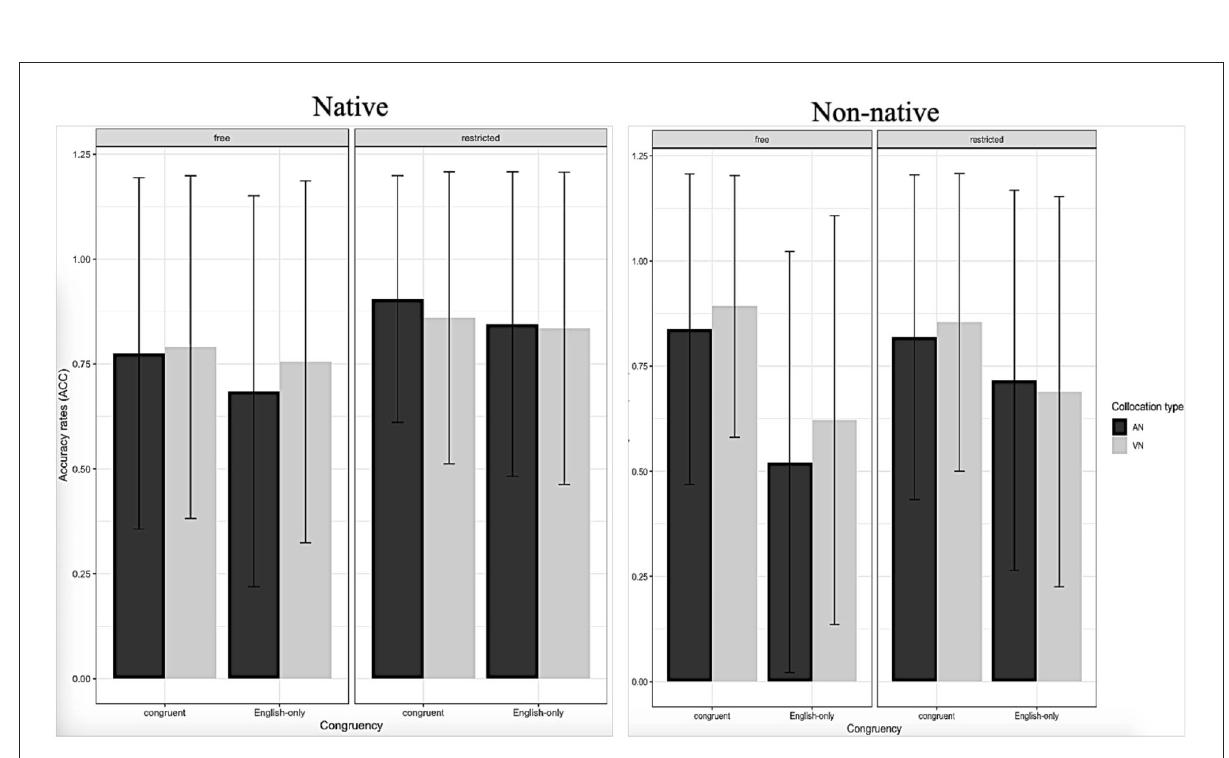
FIGURE2 Mean accuracy rates for different conditions of NSs and